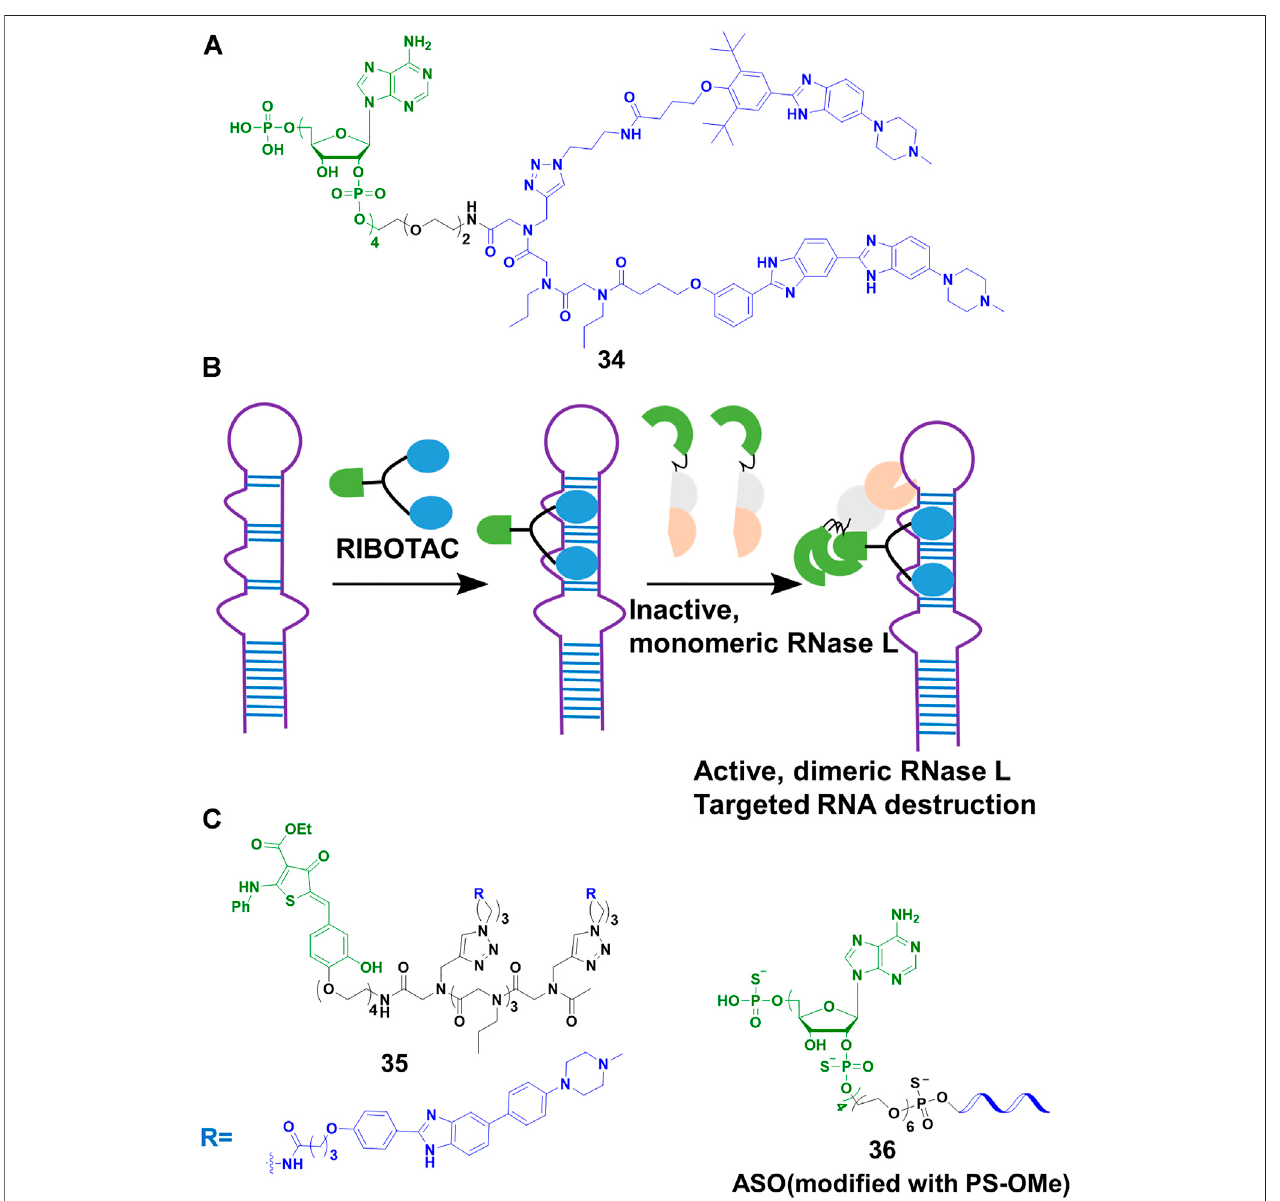
FIGURE 12 | (A) Chemical structure of RIBOTACs. (B) Action mode of RIBOTACs. (C) Chemical structure of RIBOTACs and NATACs.